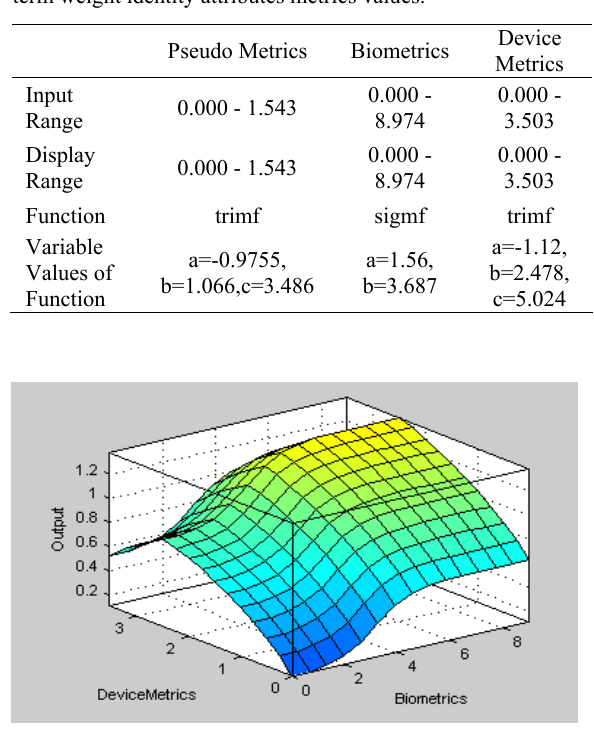
Fig. 5. Adaptive neural-fuzzy inference system surface viewer for the biometrics input, device metric inputs and the corresponding output